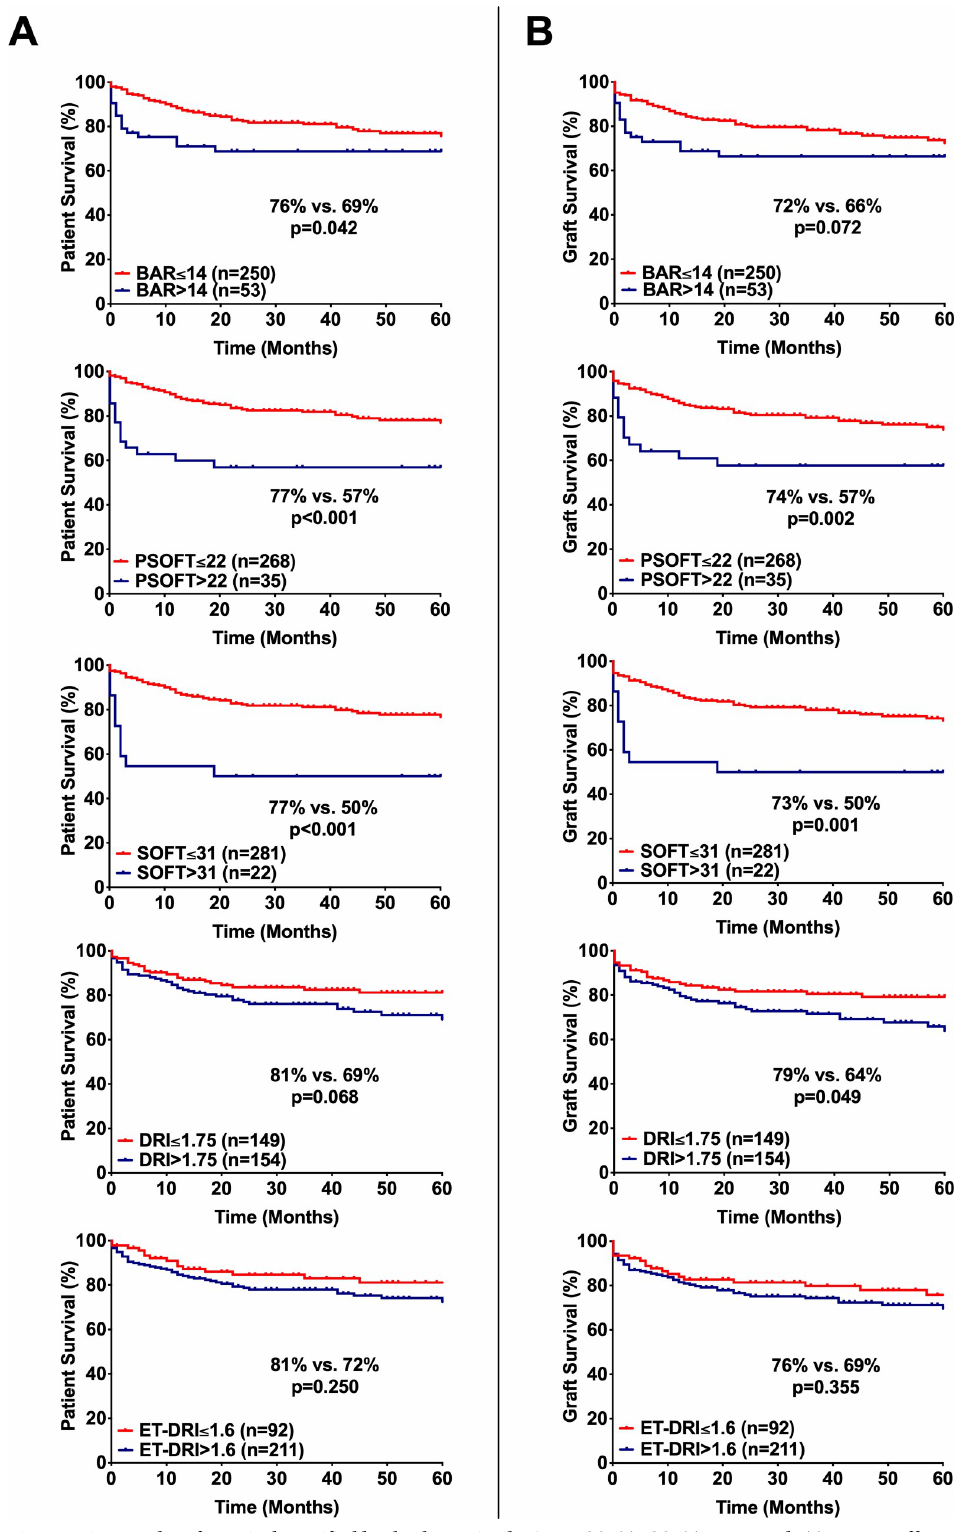
Fig 1. Patient- and graft survival stratified by the determined BAR-, pSOFT-, SOFT-, DRI- and ET-DRI-cutoff values. (A) Five-year patient survival according to the used score models. (B) Five-year graft survival according to the